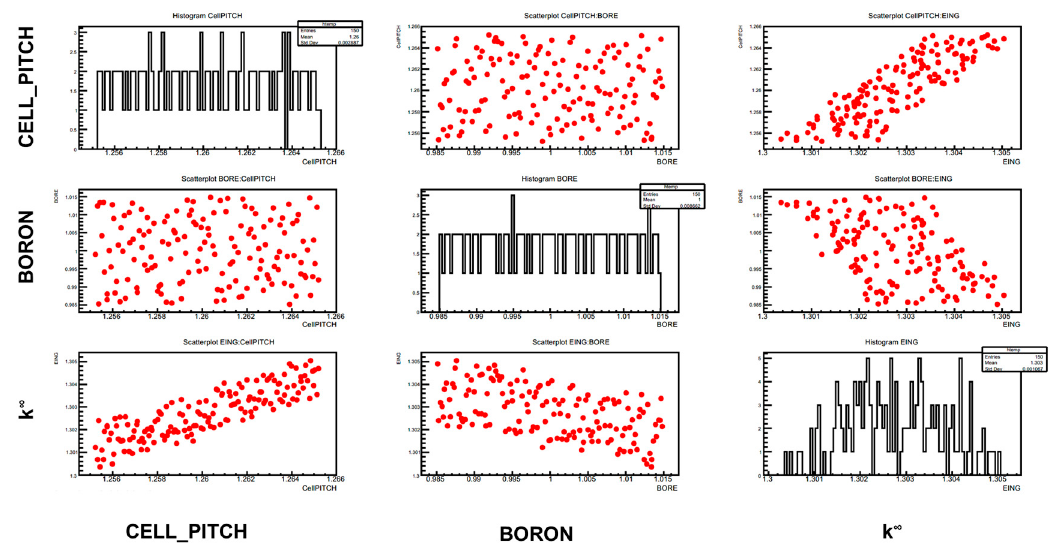
Figure 11. PWR UOX CELL: Pairs plot (FTEM, CELL_PITCH, ENRI).